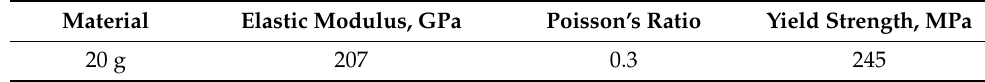
Table 2. The material parameters of the straight pipe. Material Elastic Modulus, GPa Poisson’s Ratio Yield Strength, MPa 20 g 207 0.3 245